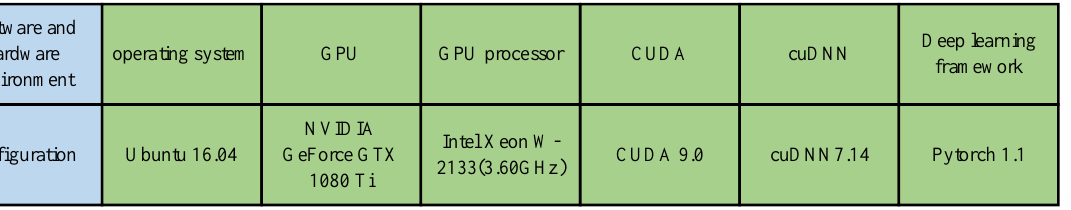
Figure 11. The experimental configurations.